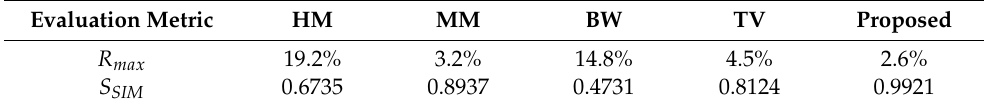
Table 1. Comparison of objective indicators for the simulations.